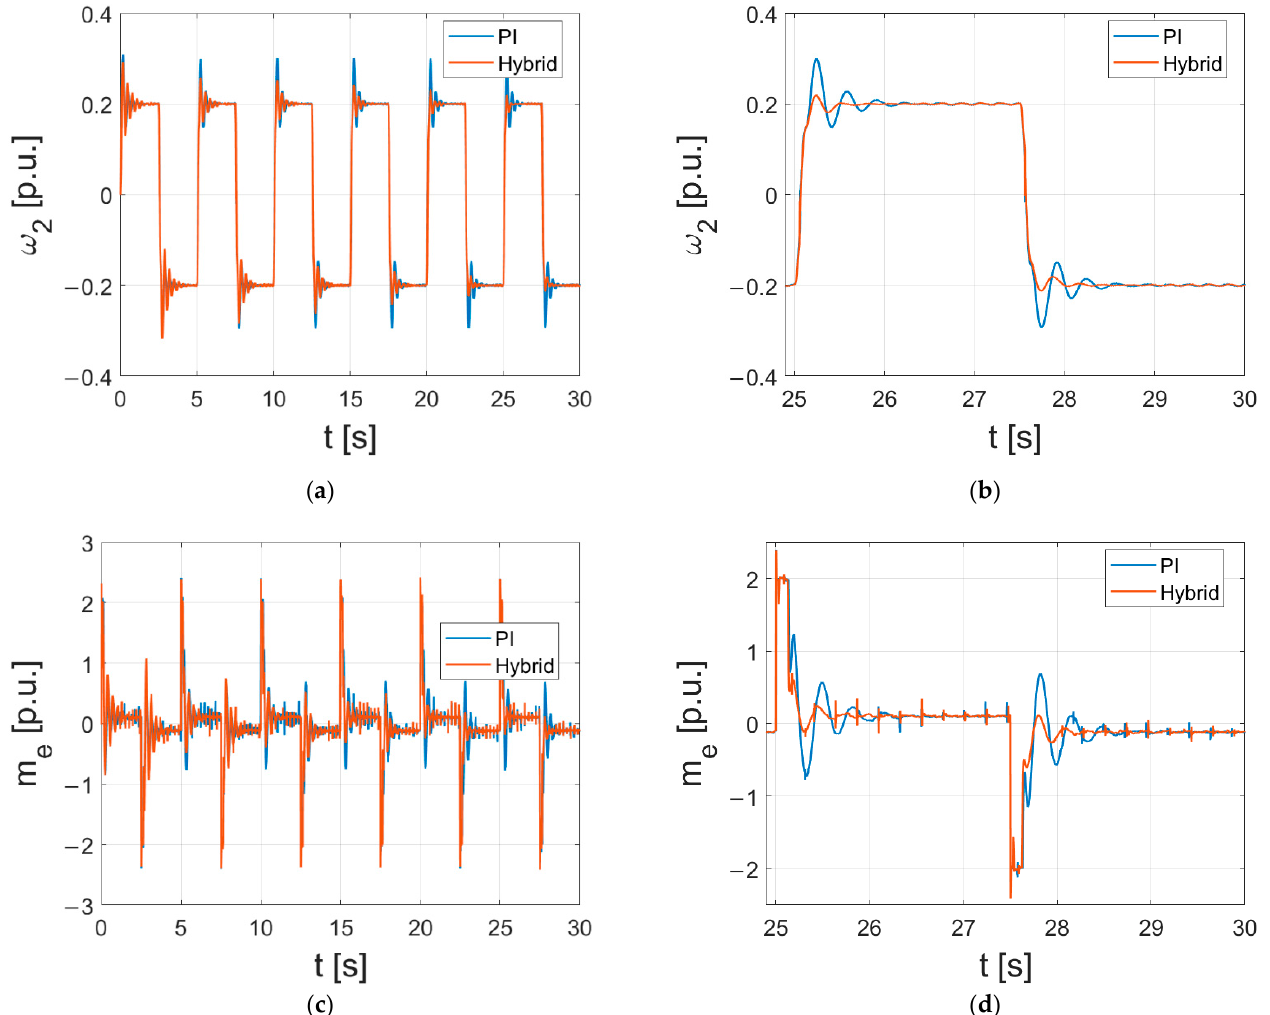
Figure 15. The comparison between the PI controller and the proposed hybrid controller—experimental results: ( a ) The angular speed of the load—a general overview of the experimental run; ( b ) a zoom-in at the final reversion of the experimental run; ( c ) the electromagnetic torque—a general overview of the experimental run; ( d ) a zoom-in at the torque during the final reversions of the experimental run.